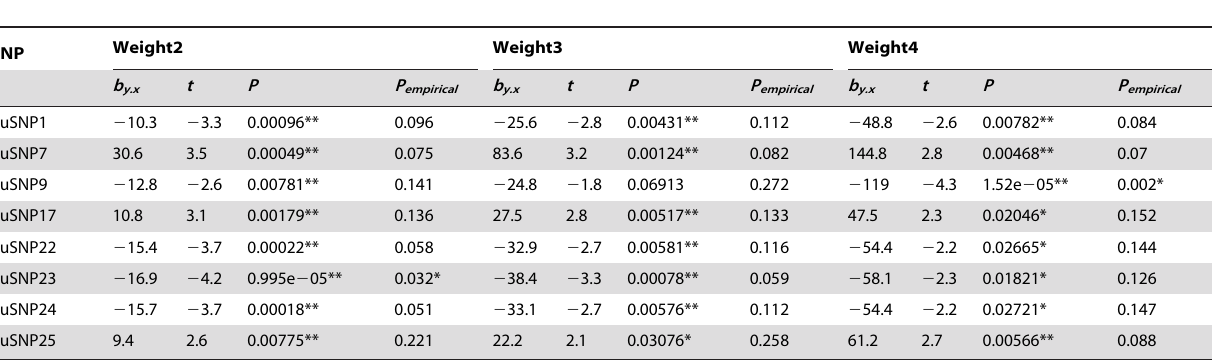
Table 1. Association of nuclear SNPs with growth traits 1 using family-based association analysis 2